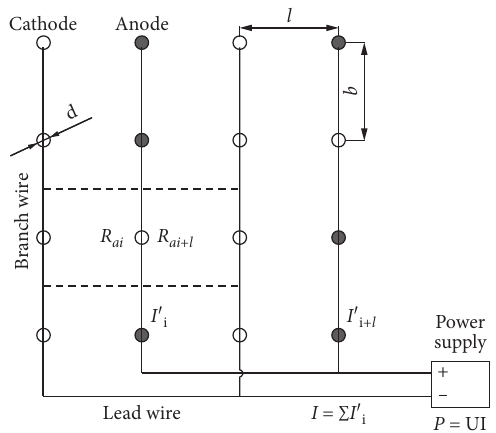
Figure 2: Schematic view of electroosmotic